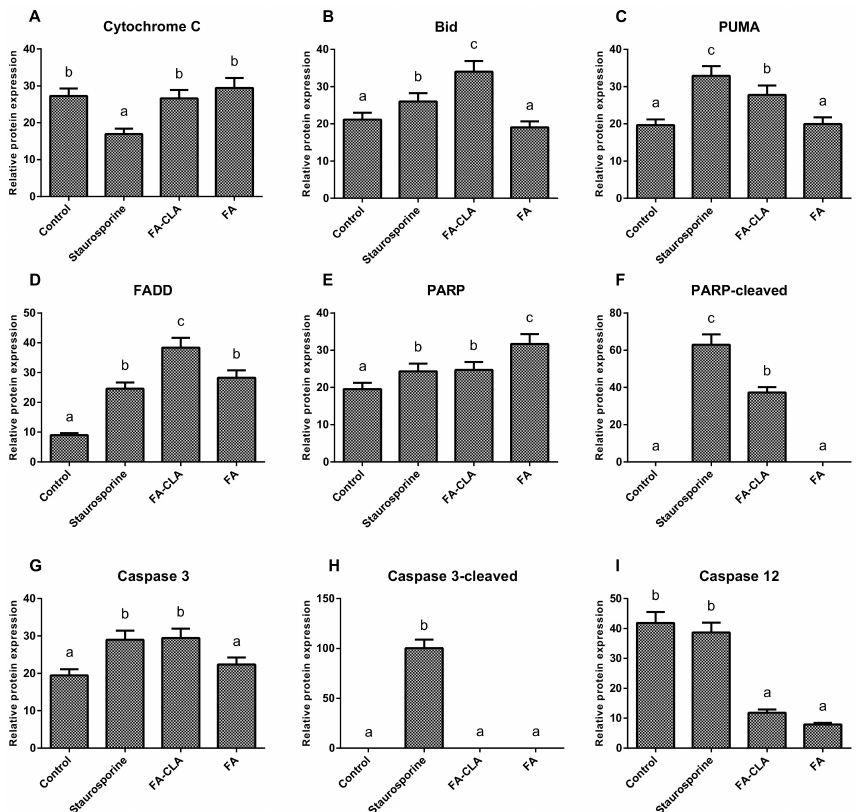
Figure 5. Effect of a mixture of fatty acids extracted from CLA-enriched and non-enriched yolk on the expression of individual apoptosis-related proteins in cancer cells of line WM793. The Tukey test was used for statistical analysis. Values marked with different letters are significantly different at p ≤ 0.05. ( A – I ) analyzed proteins. The results are presented as mean, ± SD for n = 4 in relation to untreated cells (control), a–c—means with the same letter are not significantly different.